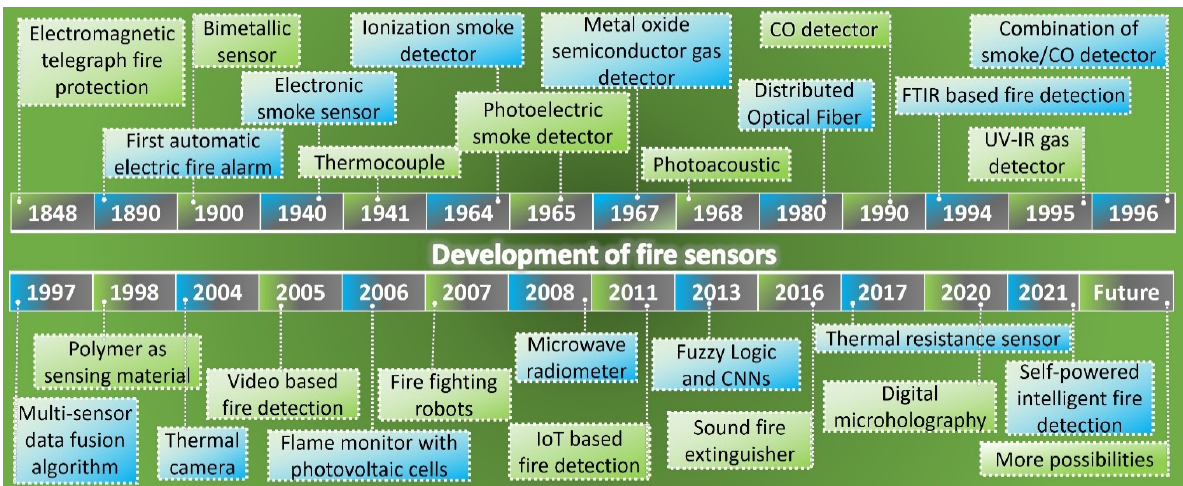
Figure 1. A brief timeline on the development of fire sensors.